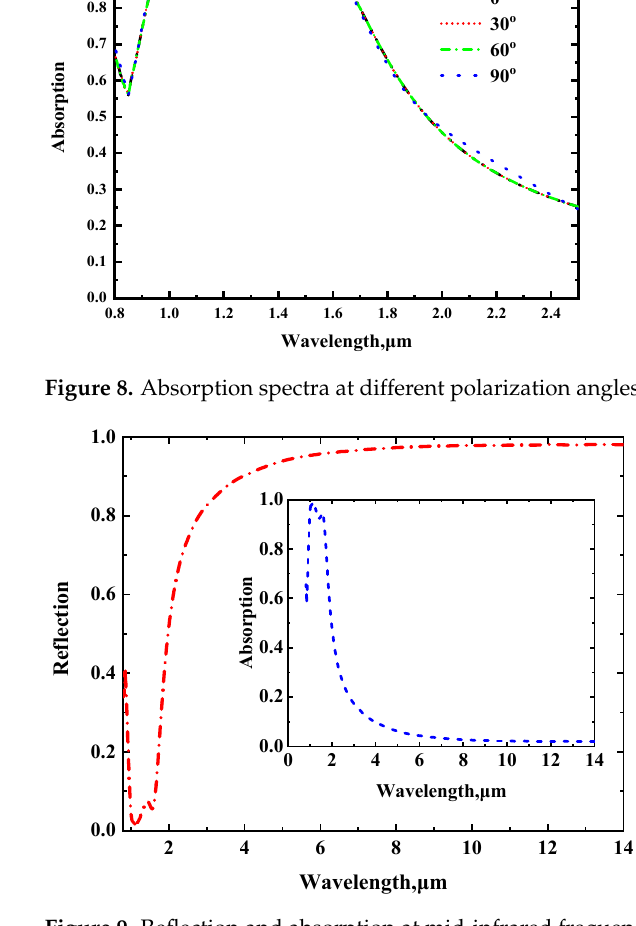
Figure 9. Reflection and absorption at mid-infrared frequencies.